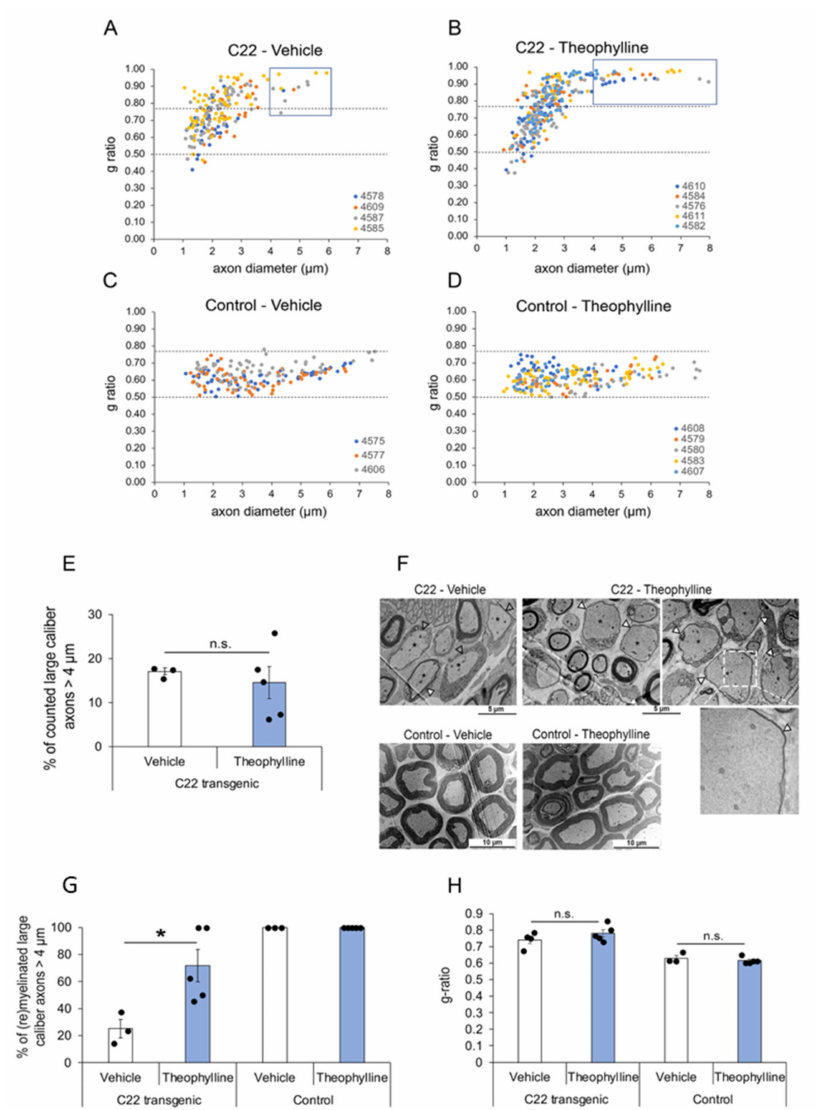
Figure 2. Theophylline induces (re)myelination of large-caliber axons. G-ratio distribution in sciatic nerves of C22 transgenic and control mice treated with Theophylline or vehicle. G-ratio/axon diame- ter scatter diagrams of sciatic nerve axons from C22 transgenic ( A , B ) and control ( C , D ) mice treated with Theophylline or vehicle as shown in Figure 1A. The data points of one animal (each identified by a unique number) are in the same color. Values above 0.77 indicate hypomyelinated axons, while values below 0.50 indicate hypermyelinated axons (delineated by dashed lines). For C22 transgenic mice treated with vehicle ( A ), the g-ratio of 203 axons is plotted ( n = 4 mice, 25–80 axons per mouse). For C22 transgenic mice treated with Theophylline ( B ), the g-ratio of 308 axons is plotted ( n = 5 mice, 35–79 axons per mouse). For control mice treated with vehicle ( C ), the g-ratio of 178 axons is plotted ( n = 3 mice, 55–62 axons per mouse). For control mice treated with Theophylline ( D ), the g-ratio of 214 axons is plotted ( n = 5 mice, 31–65 axons per mouse). The blue boxes in ( A , B ) in- dicate large-caliber axons > 4 µ m. ( E ) Graph representing the percentage of counted large-caliber axons (>4 µ m diameter) in sciatic nerves of C22 mice treated with vehicle or Theophylline. ( F ) Rep- resentative electron micrographs of sciatic nerves of C22 or control mice treated with vehicle or Theophylline. The dashed white box on the top right image highlights the region corresponding to the magnified image underneath showing a thin myelin sheath (filled arrowhead) around this large- caliber axon. ( G ) Graph representing the percentage of (re)myelinated large caliber axons (>4 µ m) in sciatic nerves of C22 or control mice treated with vehicle or Theophylline. Unpaired